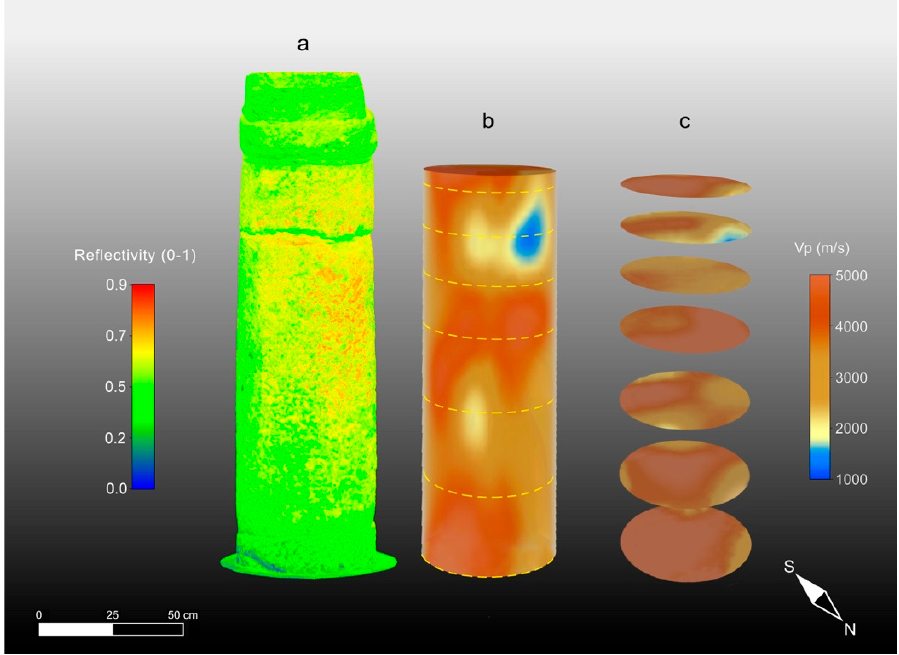
Figure 15. High-resolution 3D models of column 2. ( a ) TLS reflectivity model; ( b ) ultrasonic tomog- raphy; ( c ) tomographic slices.